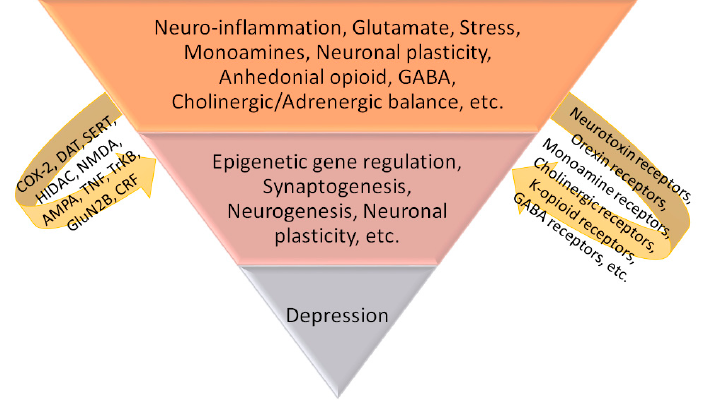
Figure 1. Factors contributing to the pathophysiology of depression.